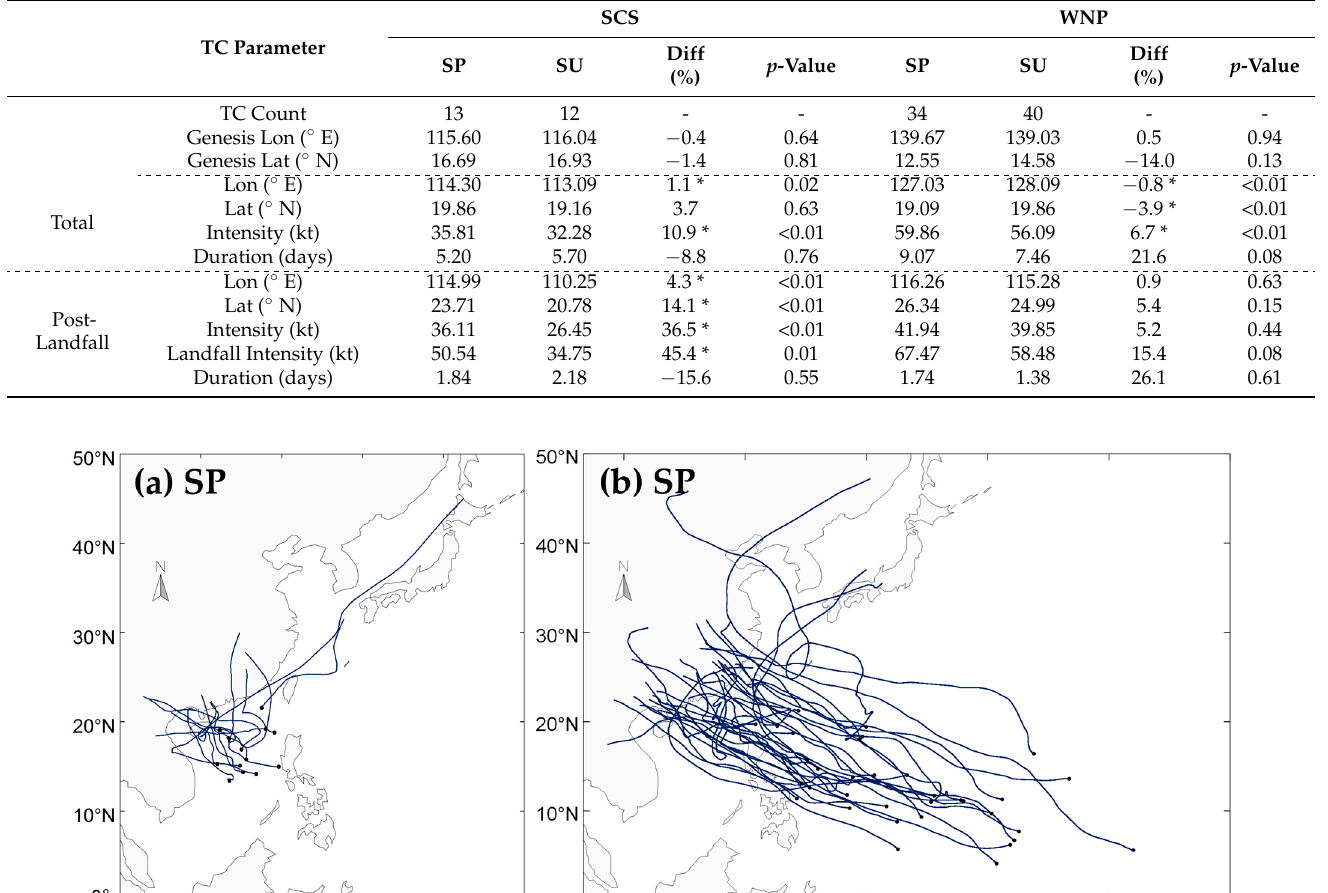
Table 3. The TC parameters of landfalling TCs with different genesis locations (i.e., the SCS and WNP) in SP and SU El Niño years. The total represents the entire track of each TC, and post-landfall represents the post-landfall track of each TC. The differences (Diff) were the rates of change in SP El Niño years relative to SU El Niño years. A * indicates statistical significance at the 95% confidence level, based on the Wilcoxon–Mann–Whitney test. The p -value is the statistical significance of the differences (Diff).